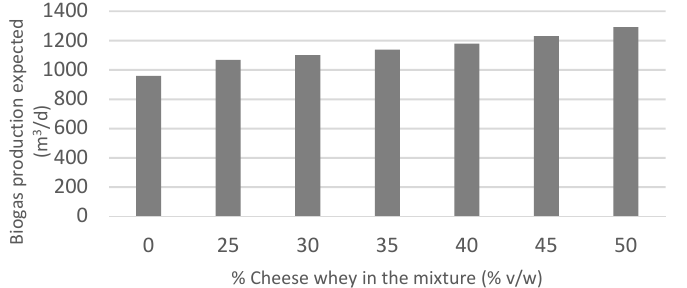
Figure 3. Daily biogas production obtained from the addition of different co-substrate proportions to the mixture (the mixture is composed of cheese whey and cattle manure). The value of 0 in the graph stands for the baseline case where no co-substrate addition is implemented. Substrate addition was made as a percentage representing volumetric addition of cheese whey to the global mass of the feeding mixture.